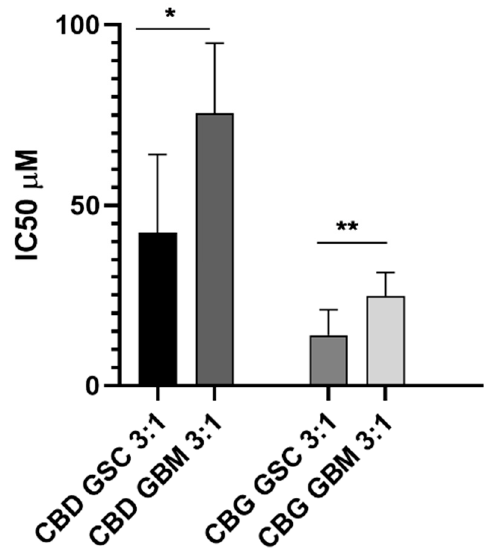
Figure 7. Cytotoxicity of cannabidiol (CBD) and cannabigerol (CBG) mixtures on glioblastoma (GBM) cells and GBM stem cells (GSCs). Mean IC50 values for GSCs ( n = 8) and differentiated GBM cell lines ( n = 10) treated with CBD and CBG (at a molar ratio of 3:1) taken from Table 2 are presented as bars of the mean cytotoxic effects, expressed in mean CBD and CBG absolute concentrations. The paired t-test was used to evaluate statistical difference (* p < 0.0105, ** p < 0.0094).